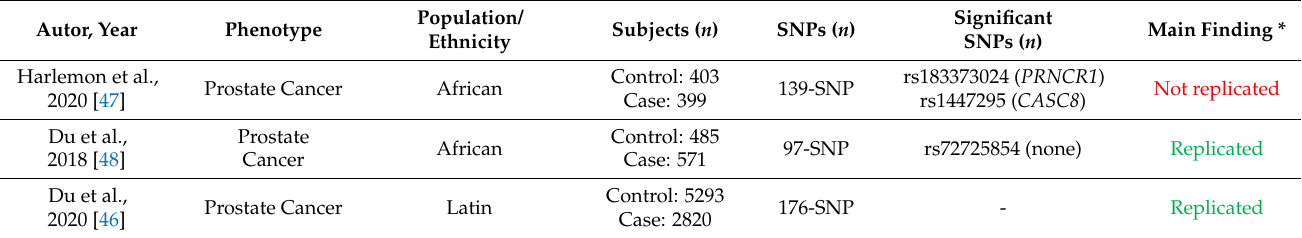
Table 2. Polygenic risk scores established for prostate cancer in multiethnic populations.